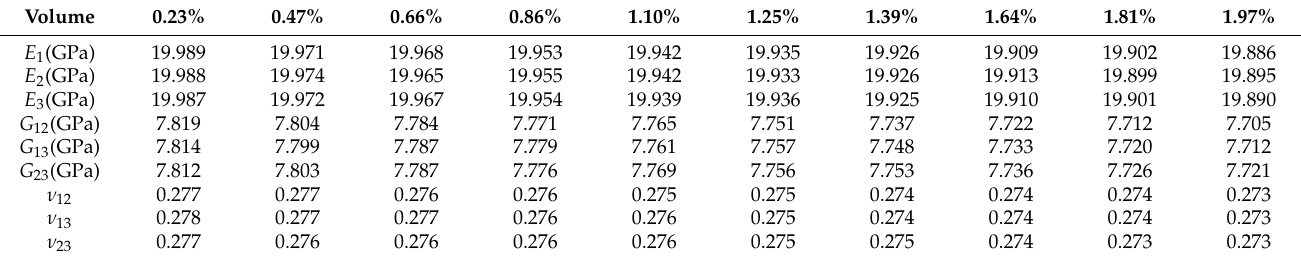
Table 4. Equivalent linear elastic mechanical properties of fiber-reinforced matrix composites.